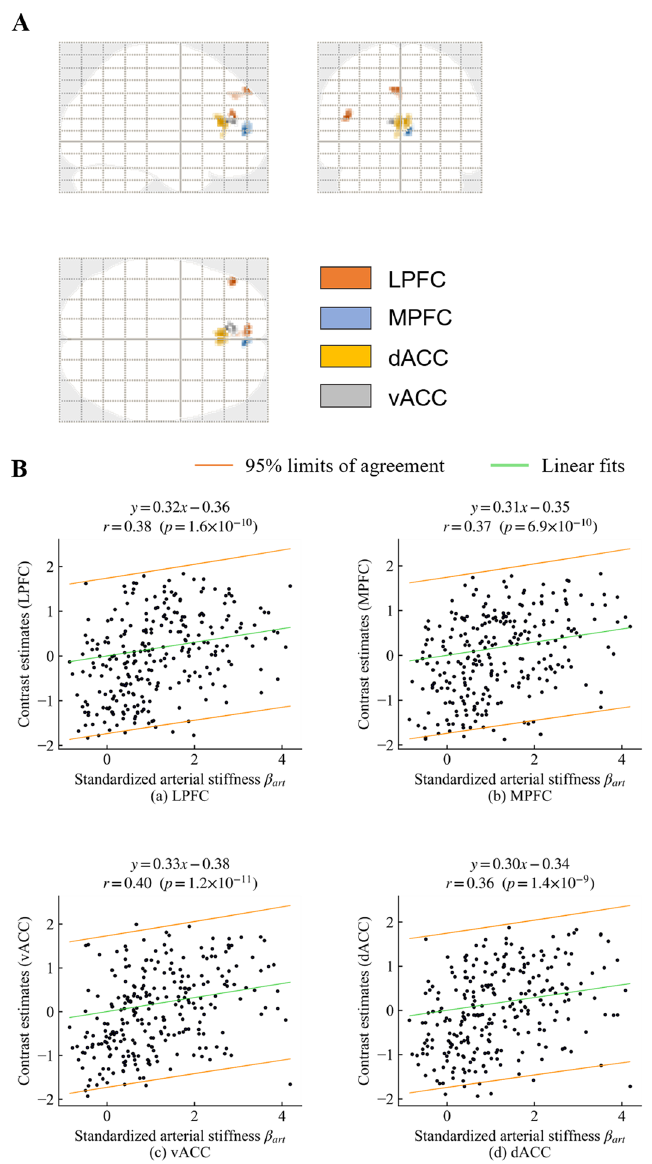
Figure 7. Parametric analysis results. ( A ) The brain regions in which BOLD signals covaried with peripheral arterial stiffness. The regions that are consistent with the pain matrix are highlighted by warm colours. ( B ) The relationship between standardised peripheral arterial stiffness ( β art ) and average contrast estimates in the significant clusters of voxels that were consistent with the pain